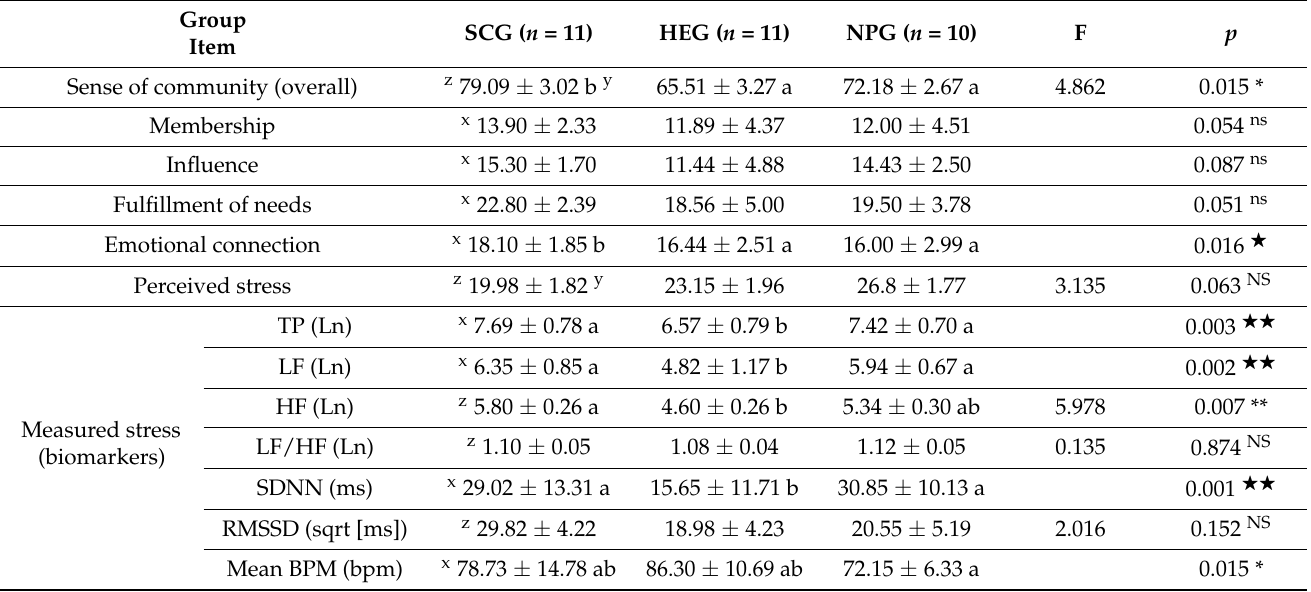
Table 7. Post-intervention comparison of the sense of community and stress among the three groups.